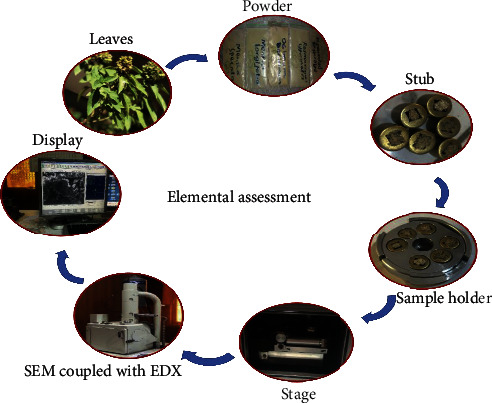
Elemental analysis.